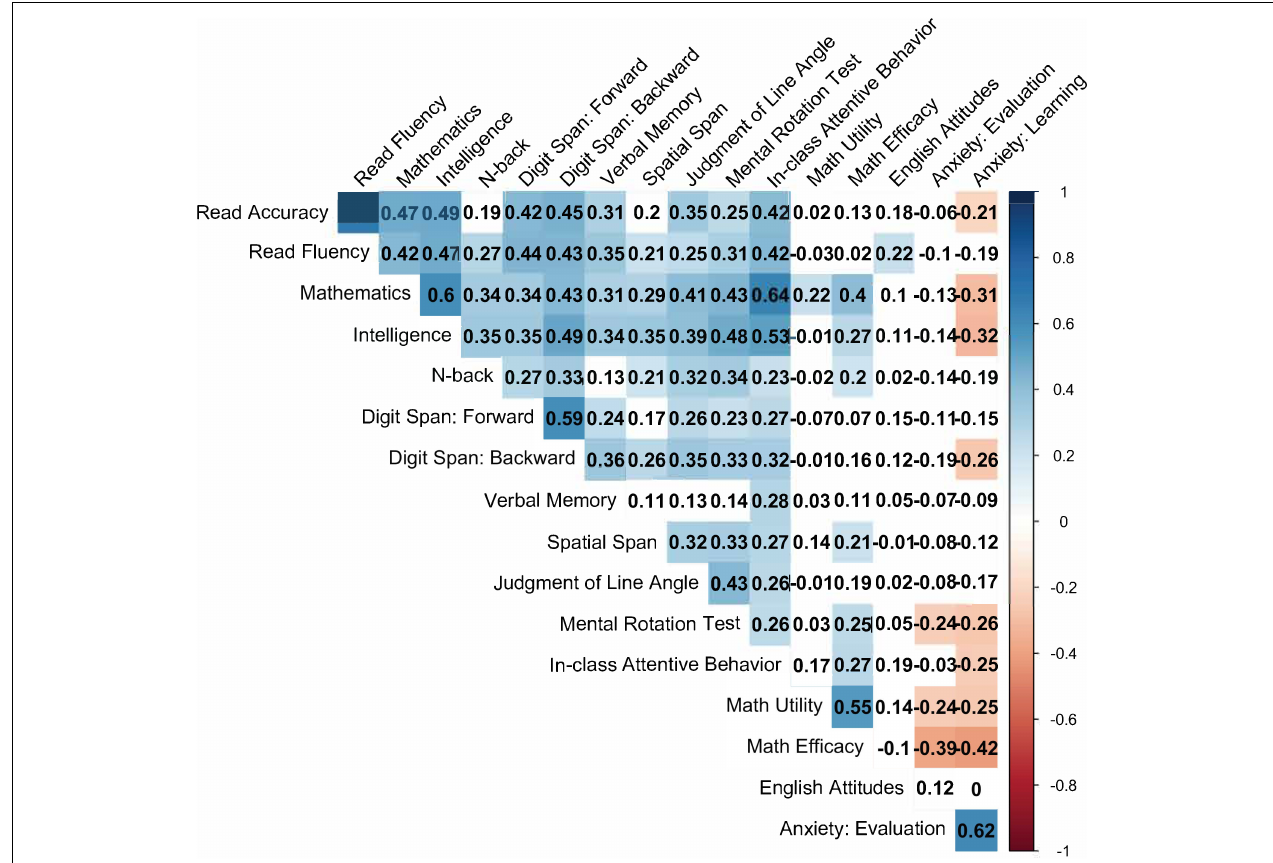
FIGURE 1 | Correlations among predictors and reading and mathematics